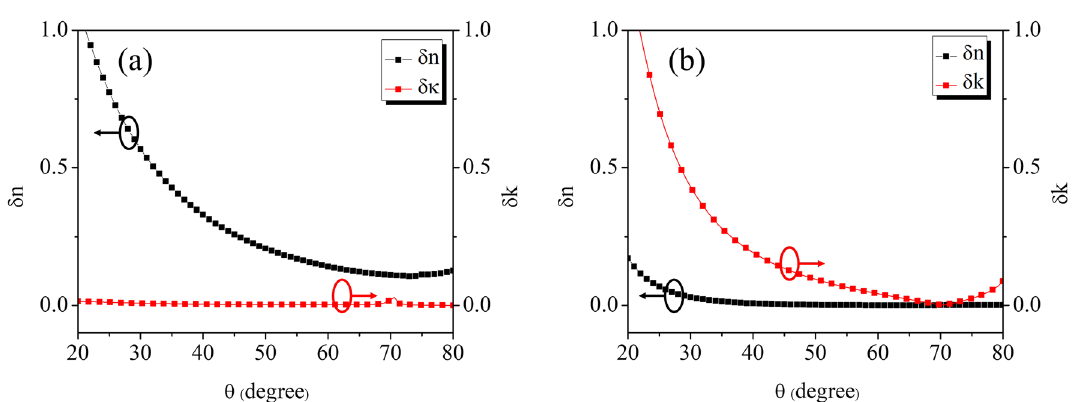
Figure 5. Deviations δ n and δ k of the Silicon complex refractive index estimated through ellipsometric angles measurements at 0.4 THz varying the signal incidence angle, with respect to reference values yielded using TDS. ( a ) (cid:31) ± 1 ◦ , (cid:31) constant. ( b ) (cid:31) ± 1 ◦ , (cid:31)